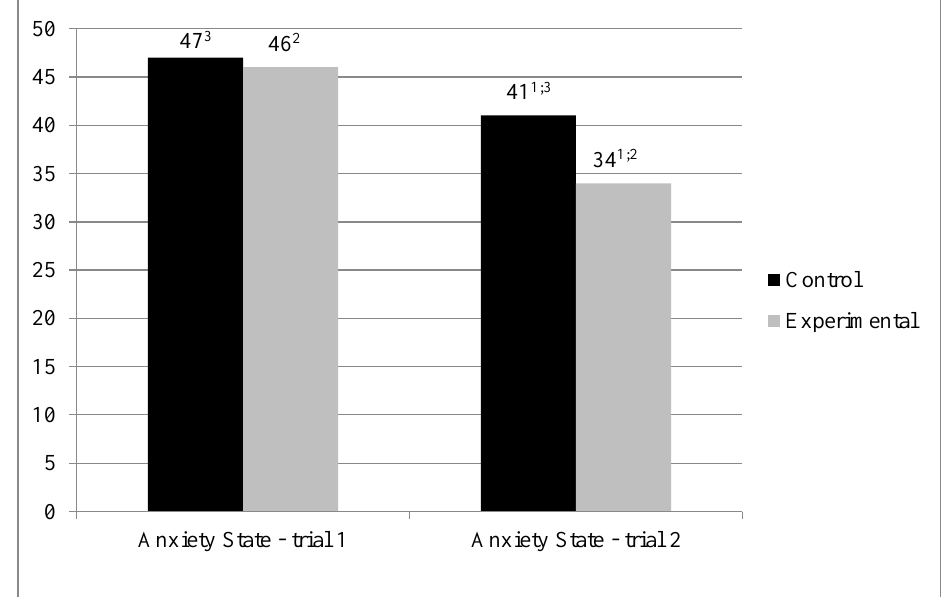
Figure 1. Average anxiety as a state (STAI). 1 — in the 2nd trial state anxiety in the treatment condition was significantly lower than in the control condition ( p < 0.05). 2 — significant difference between trial 1 and 2 in treatment condition ( p < 0.05). 3 — significant difference between trial 1 and 2 in control condition ( p < 0.05).